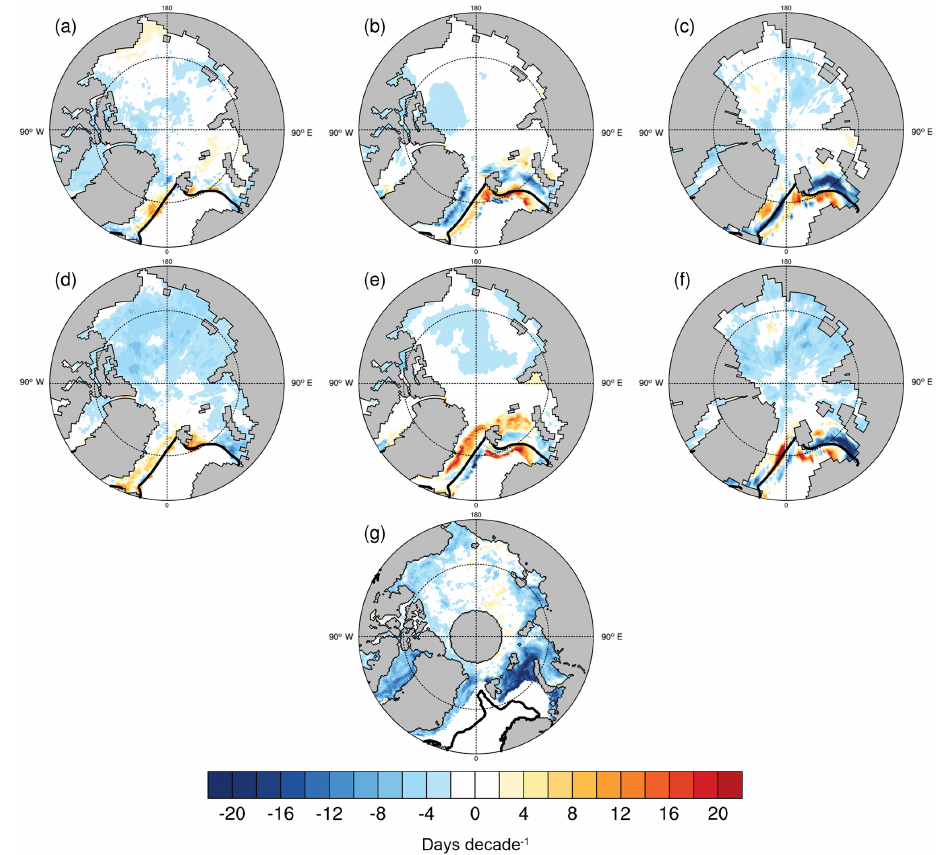
Figure 7. Trends in melt onset dates over 1979–2014 for each CESM LE definition in the two members where they are available (member 34 in a–c , member 35 in d–f ) as well as in the PMW satellite observations (g) . The snowmelt definition is shown in (a) and (d) , the thermodynamic ice volume tendency definition is shown in (b) and (e) and the surface temperature definition is shown in (c) and (f) . The black line denotes the mean March ice edge (15% ice concentration) from 1979 to 2014 using (a–f) the CESM LE and (g) NSIDC Bootstrap sea ice concentrations (Comiso,